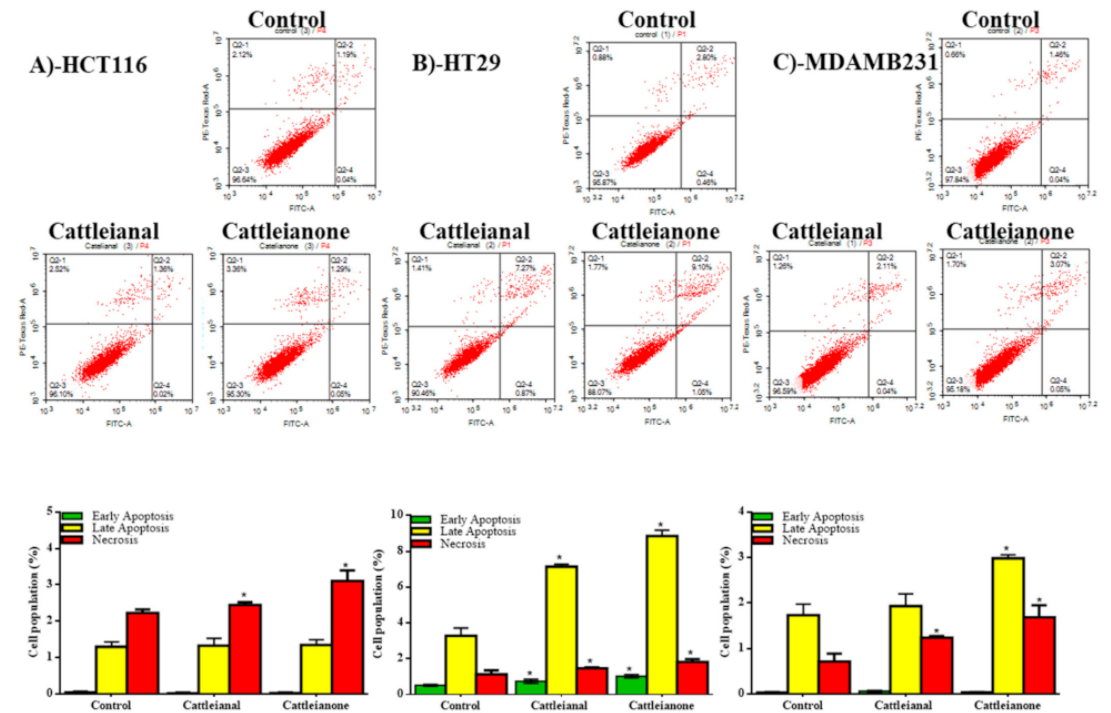
Figure 3. Apoptosis/necrosis assessment of cell population after 24 h incubation with Cattleianal and Cattleianone at their IC 50 ’s. Apoptosis/necrosis assessment and diagrammatic presentation of the results after 24h incubation of cattleianal and cattleianone with HCT-116 ( A ), HT-29 ( B ) and MDA-MB-231 ( C ) at their IC 50 . * significantly different from control p < 0.05.